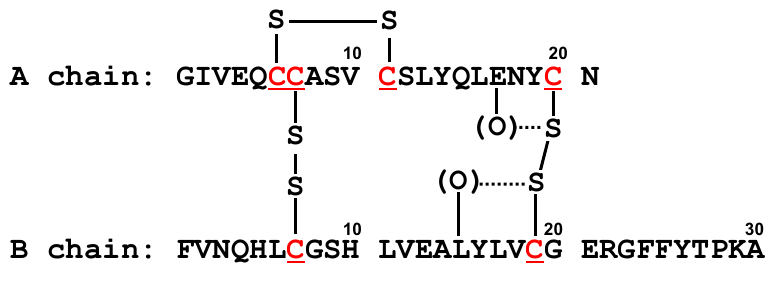
Figure 10. The amino acid sequence of bovine insulin with notations of common S···X